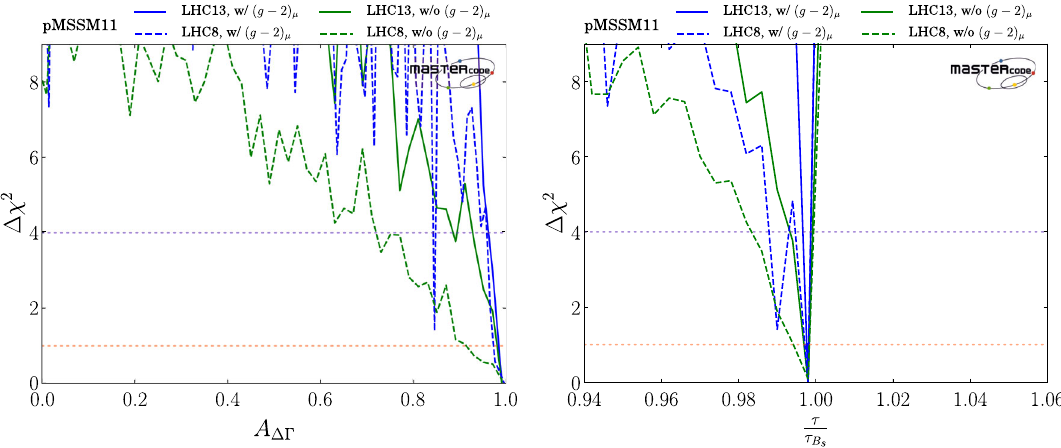
Fig. 15 One-dimensional χ 2 profile likelihood functions for A (cid:7)(cid:12) (left panel) and τ( B s → μ + μ − )/τ B the LHC 13-TeV data and ( g − 2 )